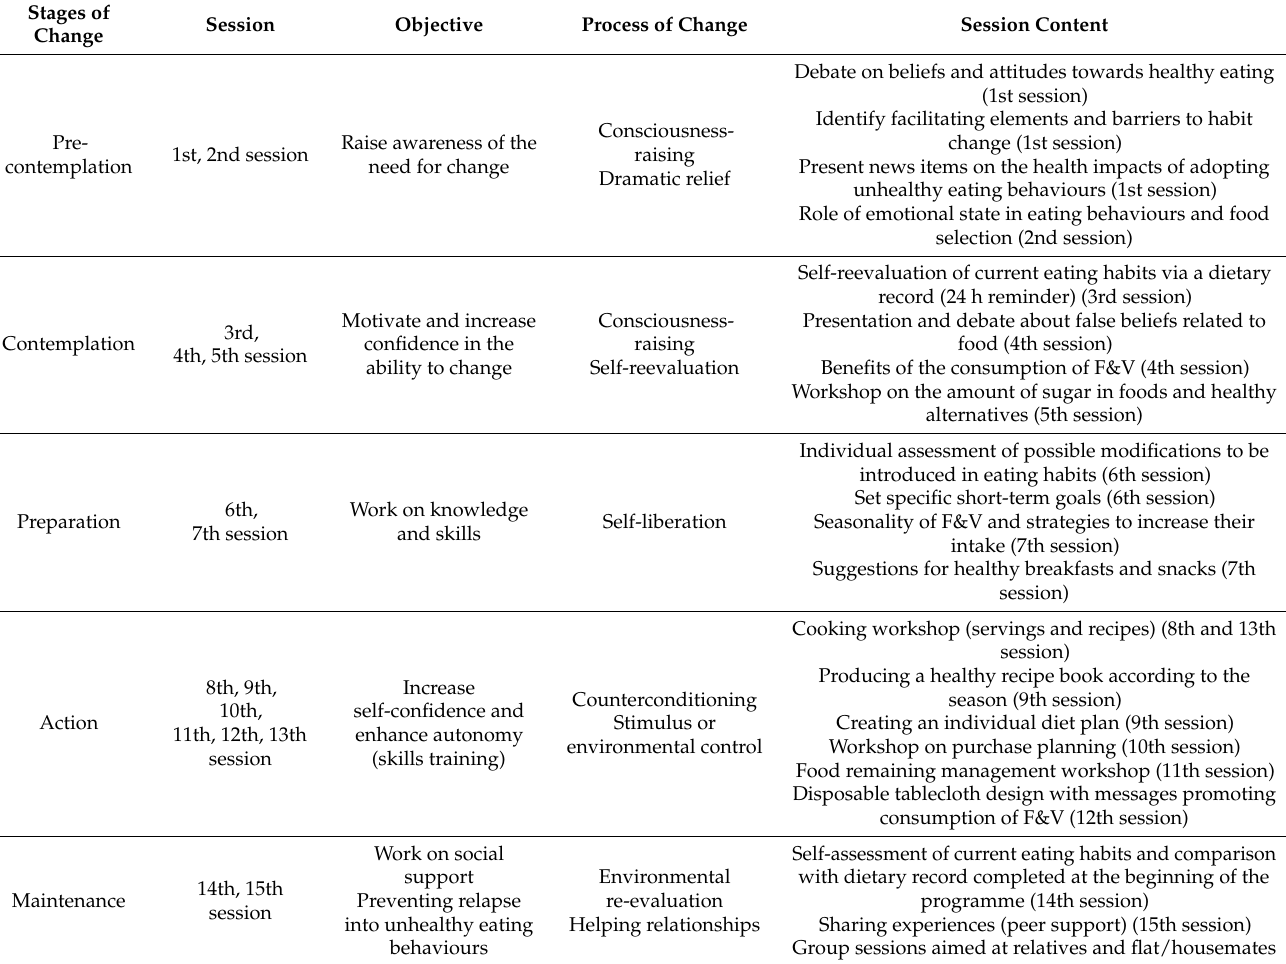
Table 1. Applying the stages of change model in design of the intervention (Dietment